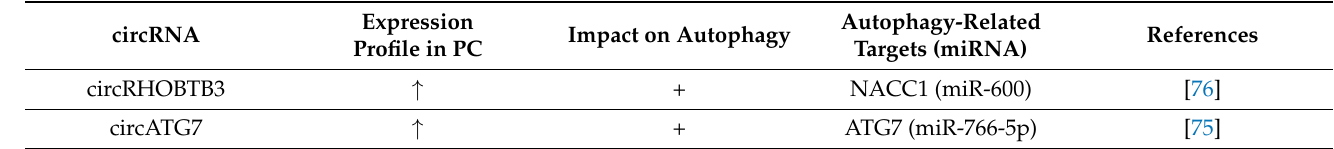
Table 3. Summary of differentially expressed autophagy-related circRNAs in